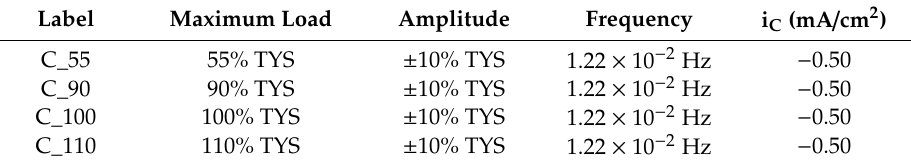
Table 1. Testing conditions of the tests on apparent hydrogen di ff usion coe ffi